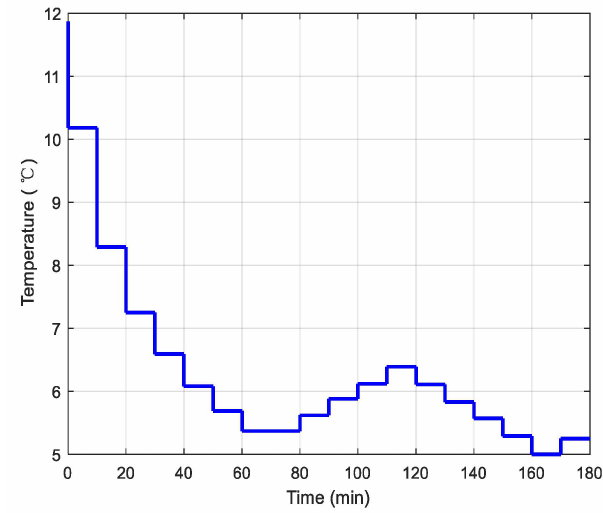
Figure 11. Control input profile for